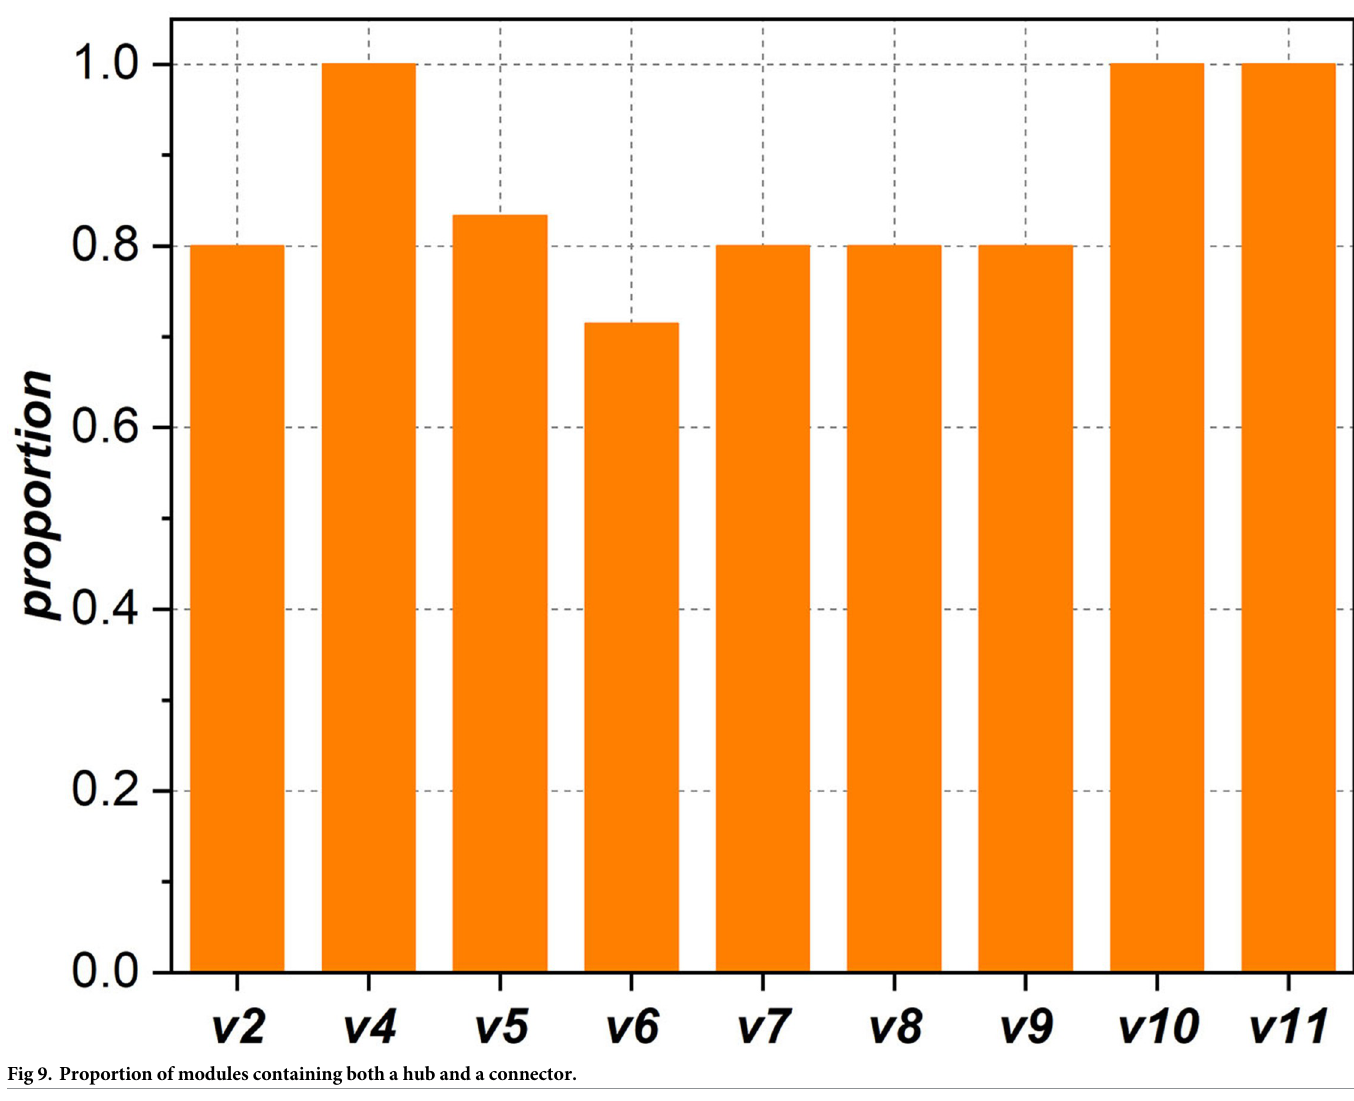
Fig 9. Proportion of modules containing both a hub and a